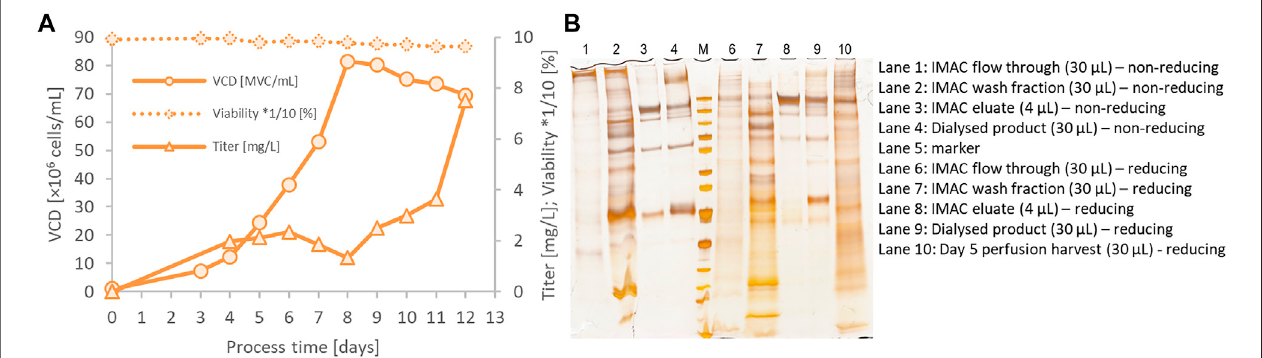
FIGURE 4 | 500 ml bioreactor perfusion run for integrated bioprocessing of the CSs spike protein using a preliminary low-producing subclone (CHO-K1 CSs 131A4) (A) .ThebioreactorharvestwascoupleddirectlytoanÄktaPuresystemequippedwithaHisTrapExcelcolumn.Onday8,cellbleedingwasstartedtokeepviable